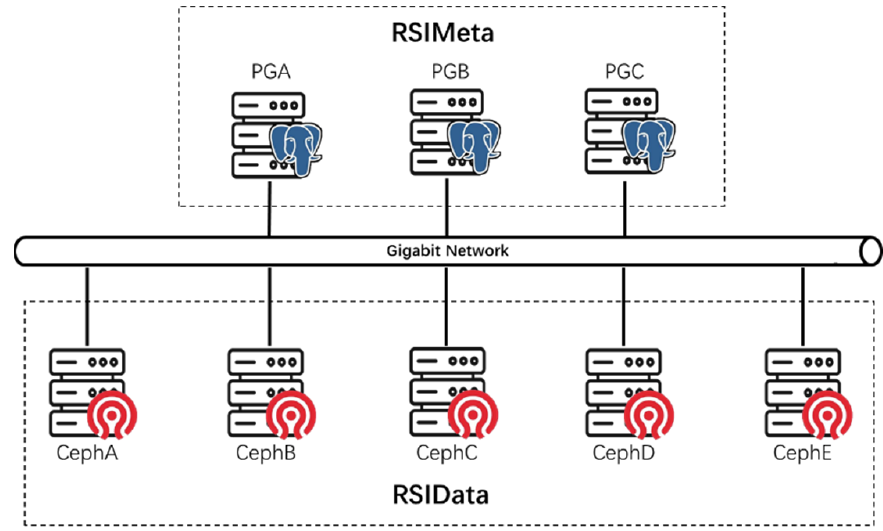
Figure 21. Deployment topology of the experimental RSIMS.